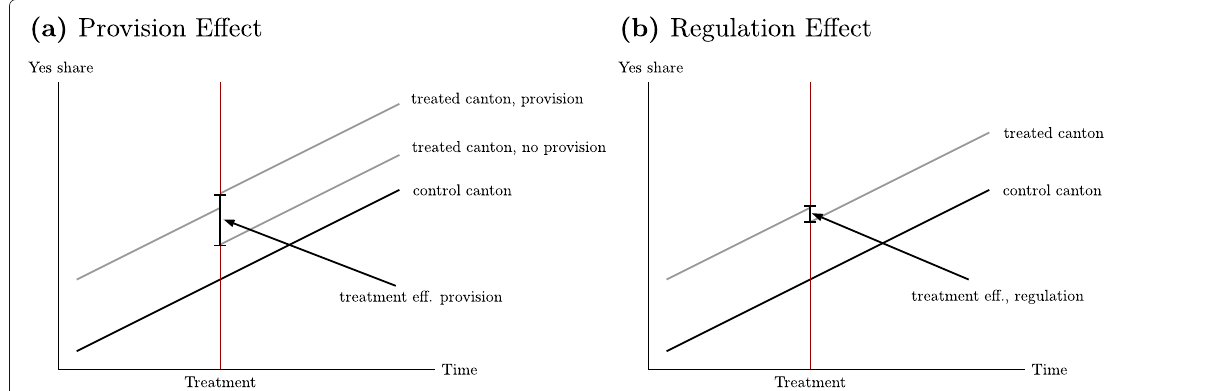
Fig. 2 This graph exemplifies the opposing provision and regulation effects. The provision effect displays the exemplified change in approval rates in the cantons with regulation, distinguishing between municipalities for which the new regulation becomes binding (due to demand for lunchtime and after-school care surpassing the 10 kids threshold) and municipalities for which the new regulation does not become binding. The regulation effect shows the hypothesized jump in approval rates on family policy related topics in cantons introducing a new regulation promoting lunchtime and after-school care compared to cantons without a change in regulation, without controlling for actual provision